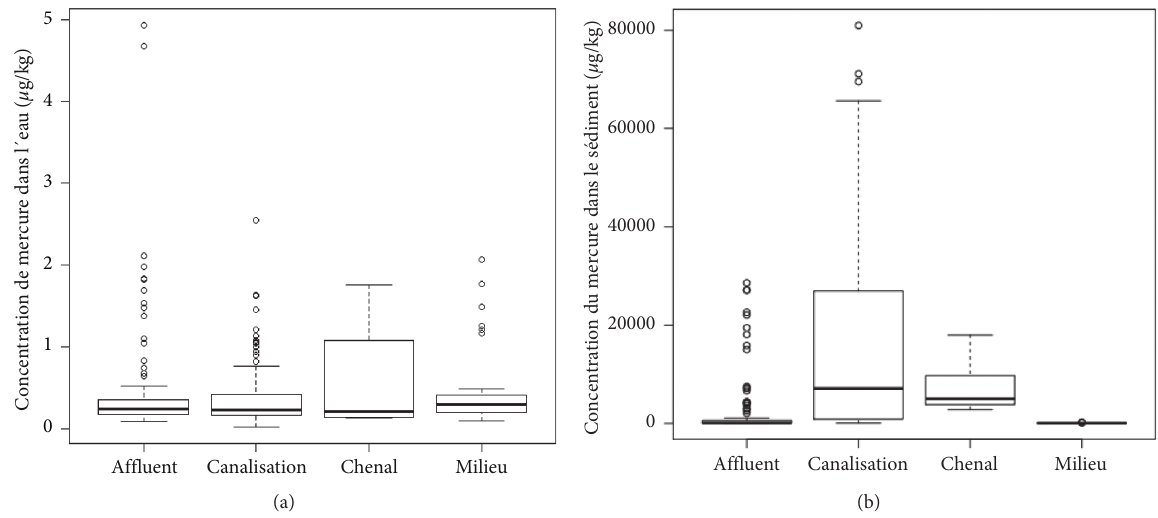
Figure 8: Global overview of the distribution of mercury in water (a) and sediment (b) by study area from July 2019 to January 2020.